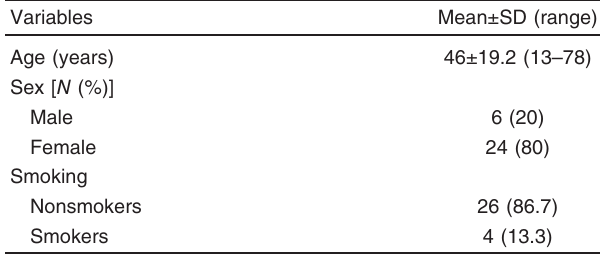
Table 1 Descriptive characteristics of all study cases